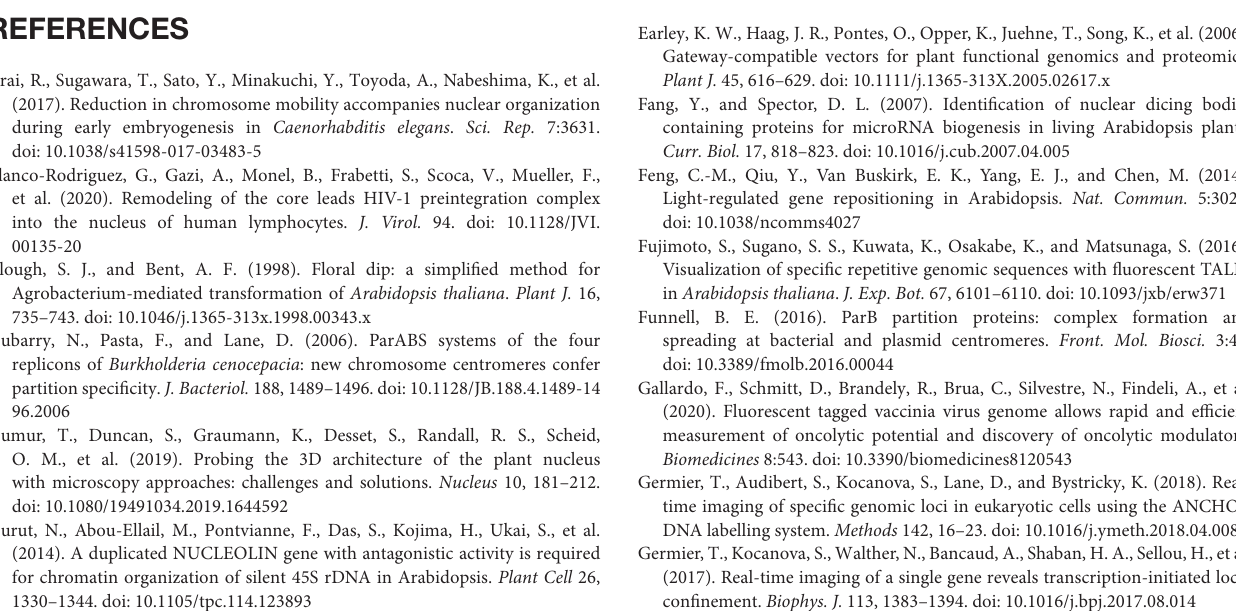
Supplementary Figure 1 | Chromatin states flanking the insertion site in T2F ANCHOR line. (A) Snapshot of the chromatin states enriched in the region flanking the transgene insertion site in the line T2F (https://jbrowse.arabidopsis.org/). ( B) Histogram representing the relative enrichment of each chromatin state in the 5kb upstream and downstream region of the transgene insertion site in the line T2F. Supplementary Figure 2 | Detection of parS -ParB foci in cells with different ploidy levels. Detection of parS -ParB:GFP foci (green) in fixed and sorted nuclei according to their ploidy levels by fluorescent-assisted cell sorting. Nuclear DNA is labeled with DAPI (gray). Supplementary Figure 3 | Pollen grain and trichome cell. Confocal images of the parS- ParB:GFP signal in a trichome cell (top panels) or in pollen grains (bottom panels). Images on the right are saturated to show the trichome contour or the pollen grains. Supplementary Figure 4 | Co-localization of parS -ParB foci with H3Ac and H3K27me3 marks. Detection of parS -ParB:GFP foci (green) and posttranslationally modified histones (red) in fixed and isolated nuclei from A. thaliana Col-0 plants T2F. Nuclear DNA is labeled with DAPI (gray). Trimethylated H3K27 signals are shown in the ( A) , while acetylated H3 are shown in ( B). (C,D) show the relative intensity of each